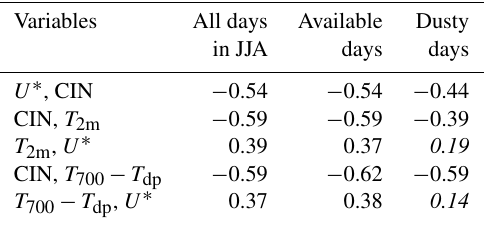
Table 2. Correlations between U ∗ and CIN, CIN and vertical wind Table 1. Correlations between friction velocity ( U ∗ ) and CIN, CIN speed at 850hPa (w850), and w850 and U ∗ during dusty days in and 2m temperature ( T 2m ) , T 2m and U ∗ , T 700 − T dp (the differences between air temperature at 700hPa and 2m dew point temperature) JJA from 2002 to 2015. All values are significant at the 95% con- and CIN, and T 700 − T dp and U ∗ for all days in JJA from 2002 to fidence level, except the value significant at the 90% confidence level, labeled with a “ + ” ( t test). 2015 (1288 days), days when fine dust concentration is available (431 days), and dusty days (52 days). All values are significant at the 95% confidence level ( t test) except those listed in italic. Variables All days Available Dusty in JJA days days − 0.54 − 0.54